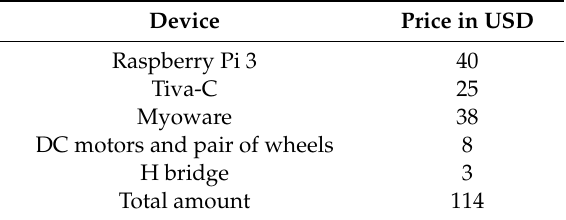
Table 4. Cost of the implemented